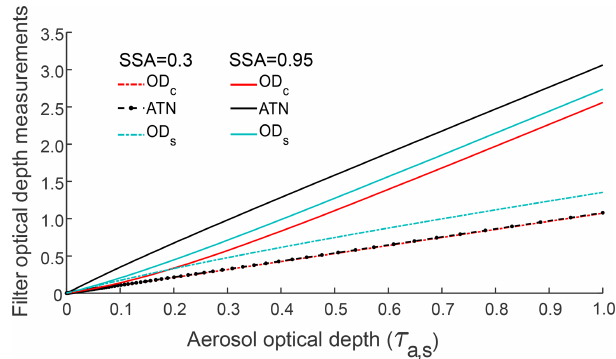
Figure 2. Modeled values of filter optical depth measures (OD c , ATN, and OD s ) with increasing aerosol optical depth ( τ a , s ) of de- posited highly absorbing (SSA = 0 . 3) or highly scattering (SSA = 0 . 95) aerosols. Fixed blank optics were assumed.